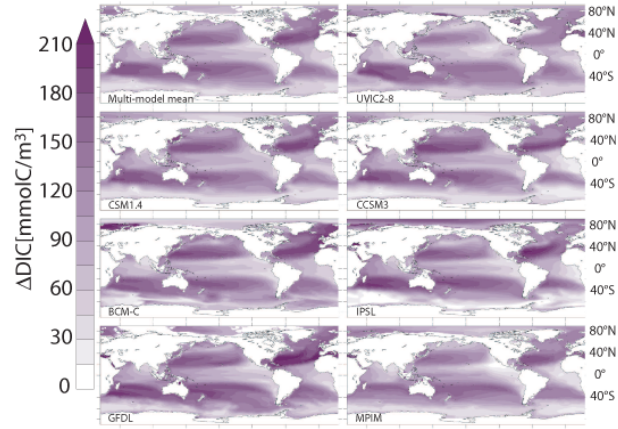
Fig. 10. Projected DIC changes in the UML (100 to 600m depth) and for 2090s relative to 1870s (decadal average). The multi-model mean is given in the upper left